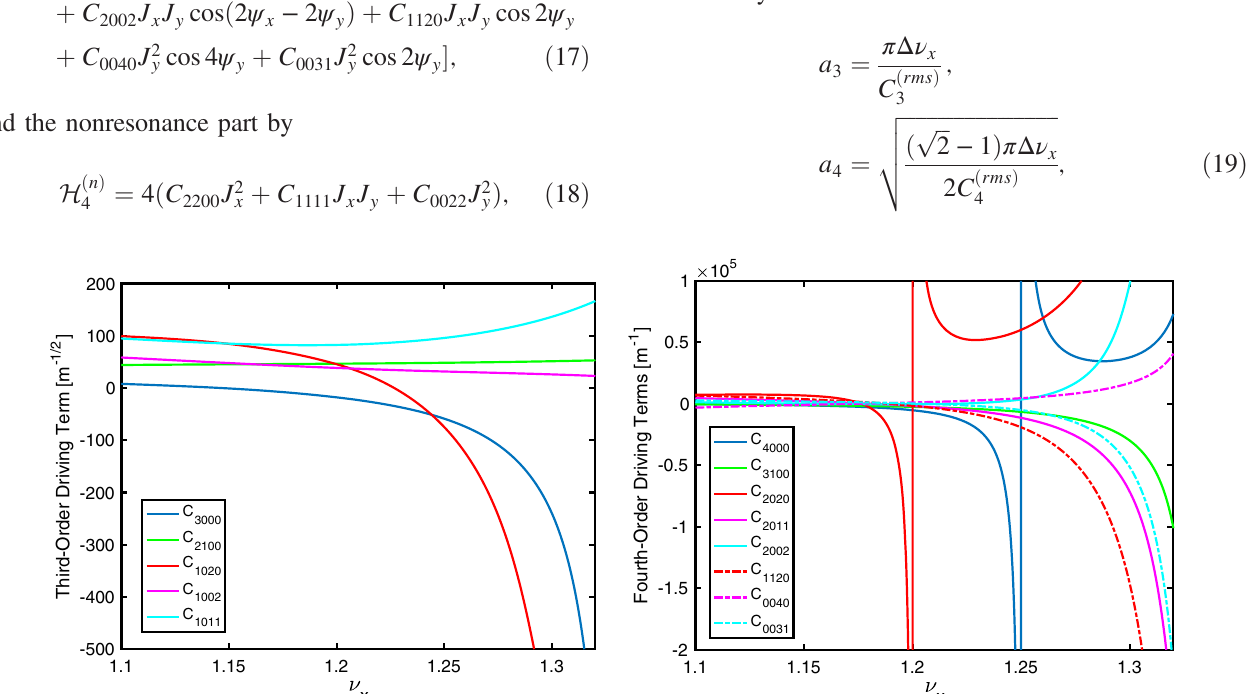
FIG. 9. The driving terms of the third- (left) and fourth-order (right) resonances as a function of the horizontal betatron tune ν fixed ratio to the vertical tune ν